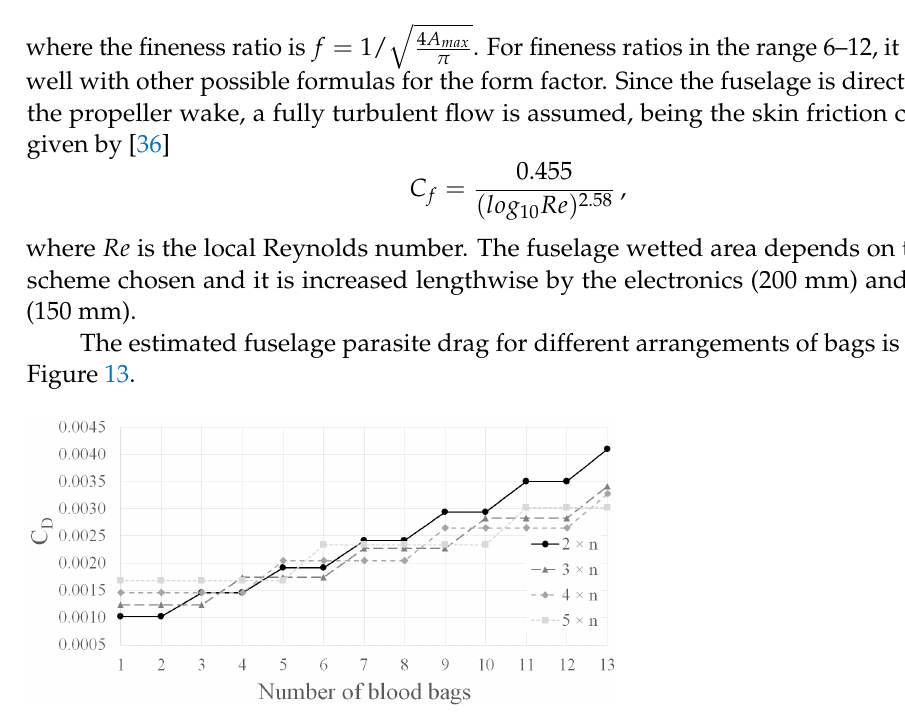
Figure 13. Fuselage parasite drag for different blood bag arrangements.